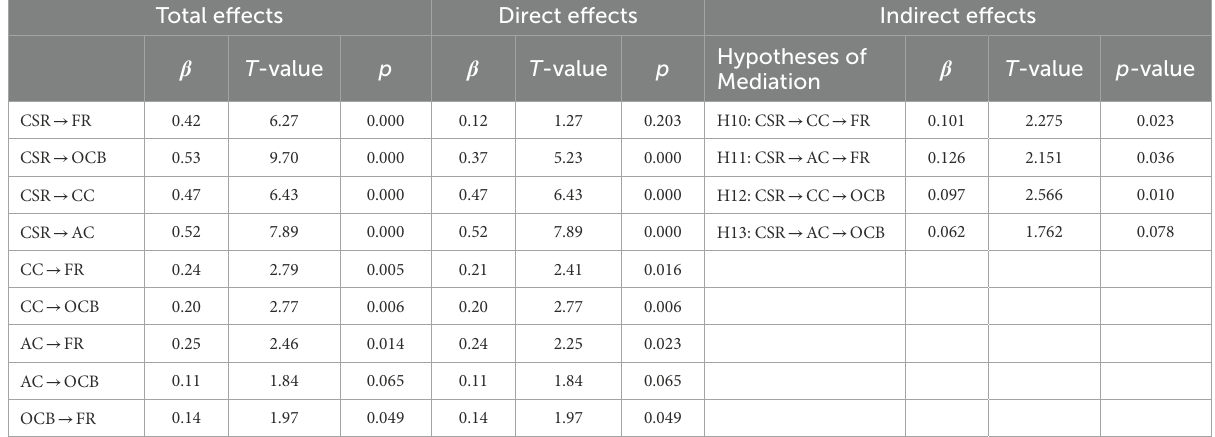
TABLE 6 Results of bootstrapping for the direct, indirect, and total effect of the hypothesized model.